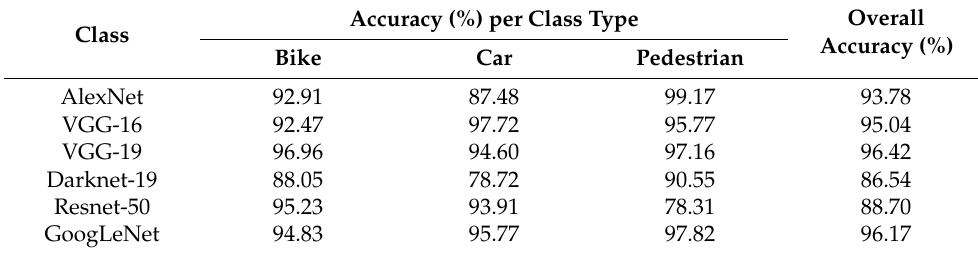
Figure 13. Sample image patches used to test the transferred CNN models. Table 4. Testing results for object classification by the transferred CNN